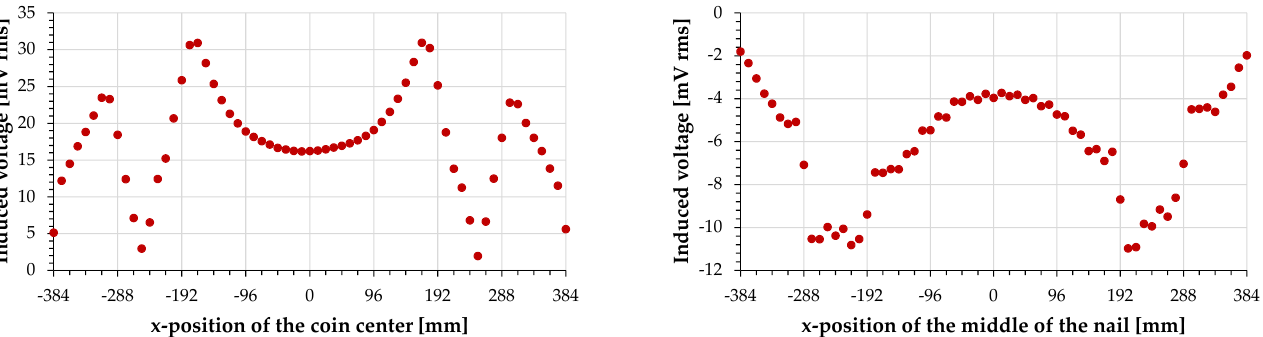
Figure 14. Calculated influence of the test objects 1 and 8 on the modified sensor coil 2 as a function of the position of the test objects taking into account offset voltage and phase angle ( left ) 0.05 e coin ( right ) Steel